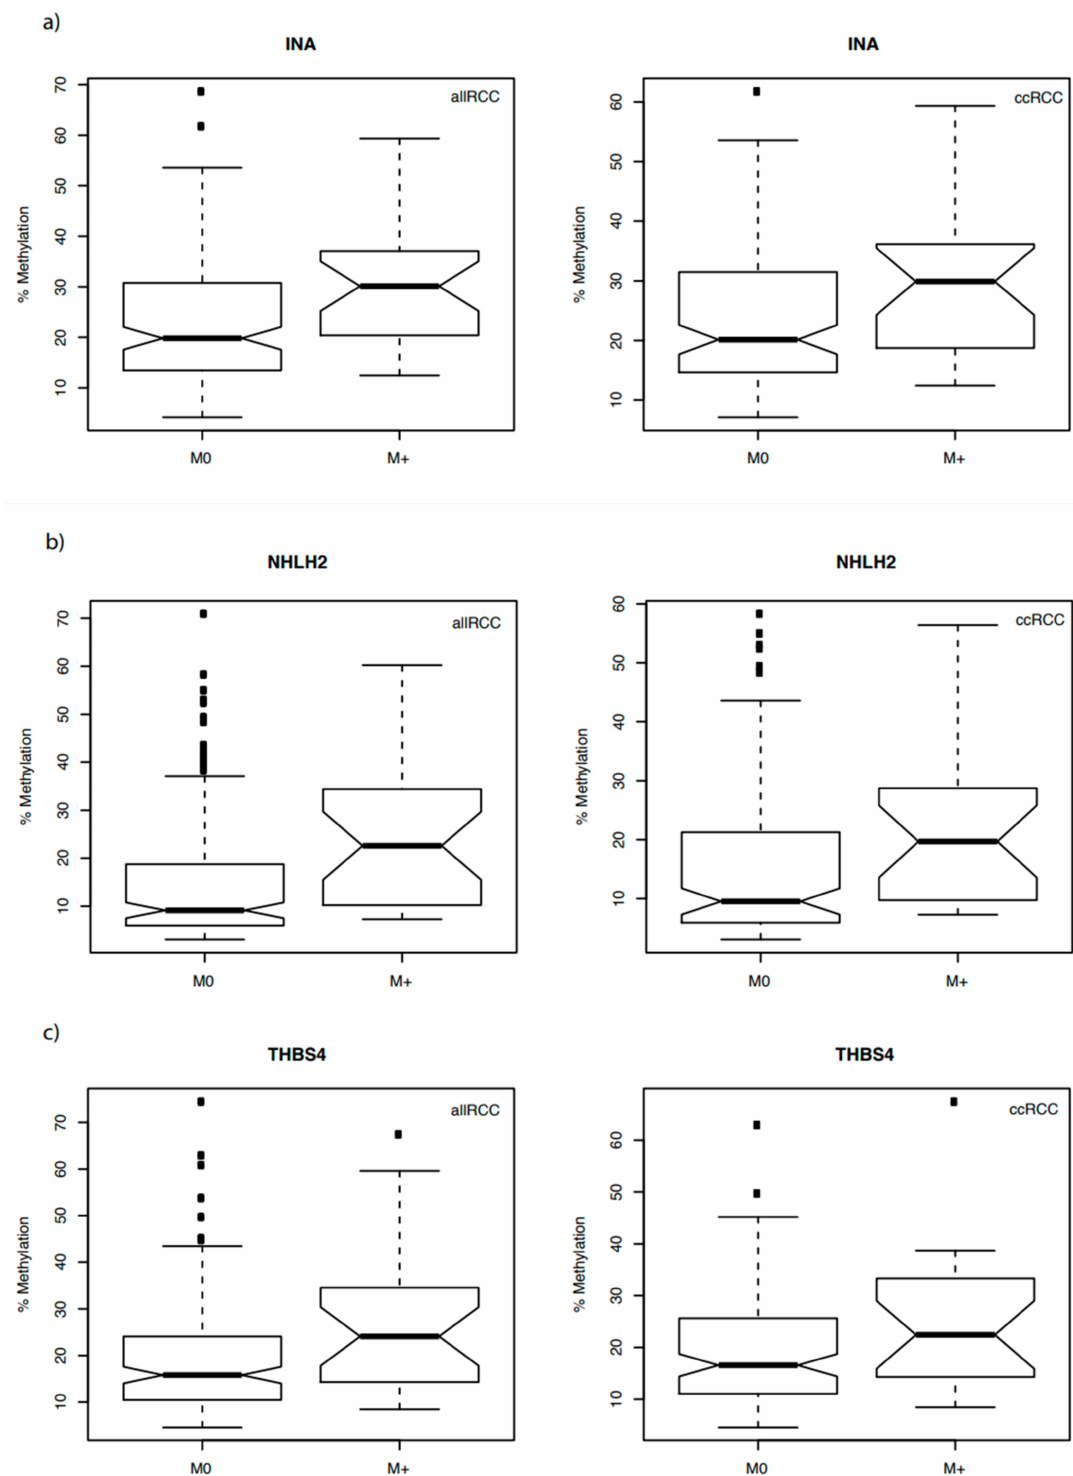
Figure 2. Box plot of INA ( a ), NHLH2 ( b ), and THBS4 ( c ) methylation in tumors without (M0) and with metastatic disease (M+) for the complete cohort (allRCC) and ccRCC subgroups. Medians are shown with the estimated confidence interval (notches), 25% and 75% quartiles. Whiskers indicate the 99.3% interval (two-sided 1.5-fold interquartile range) and black squares the outliers for the relative methylation distributions. Corresponding p -values and odds ratios are presented in Table